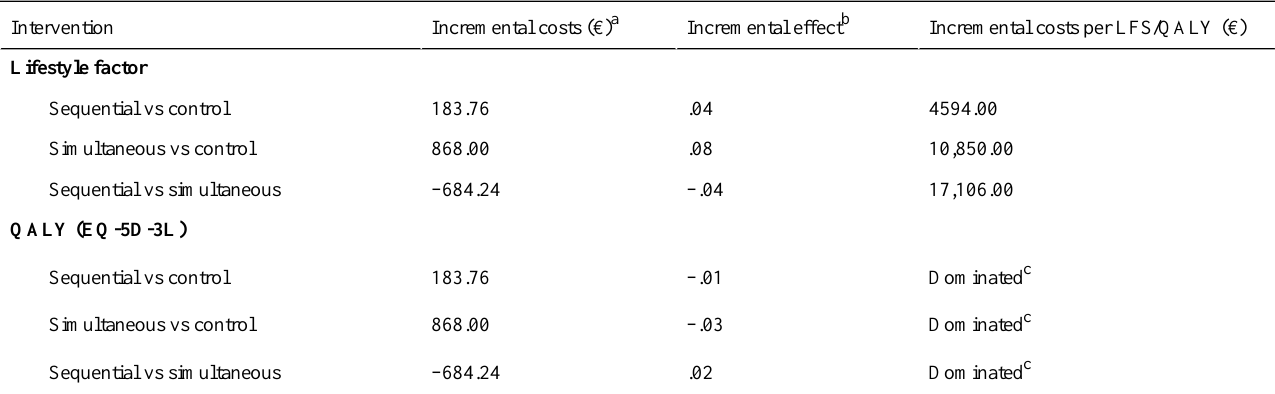
Table 4. Incremental costs and effects per gain in lifestyle factor score (LFS) and per quality-adjusted life year (QALY) gained for the study groups with a willingness-to-pay threshold of